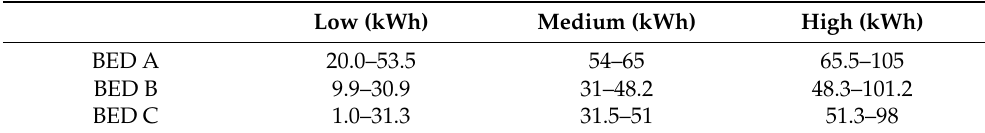
Table 7. BED thresholds (kWh).